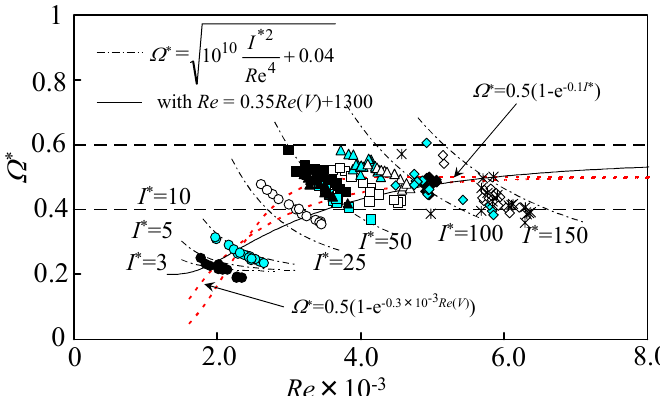
Fig. 20 Reduced rotating rate Ω * of a tumbling plate versus Reynolds number Re , for several values of inertia-moment ratio I * at depth-to-width ratio λ = 0.3, aspect ratio AR = 10, C = 3.86 × 10 2